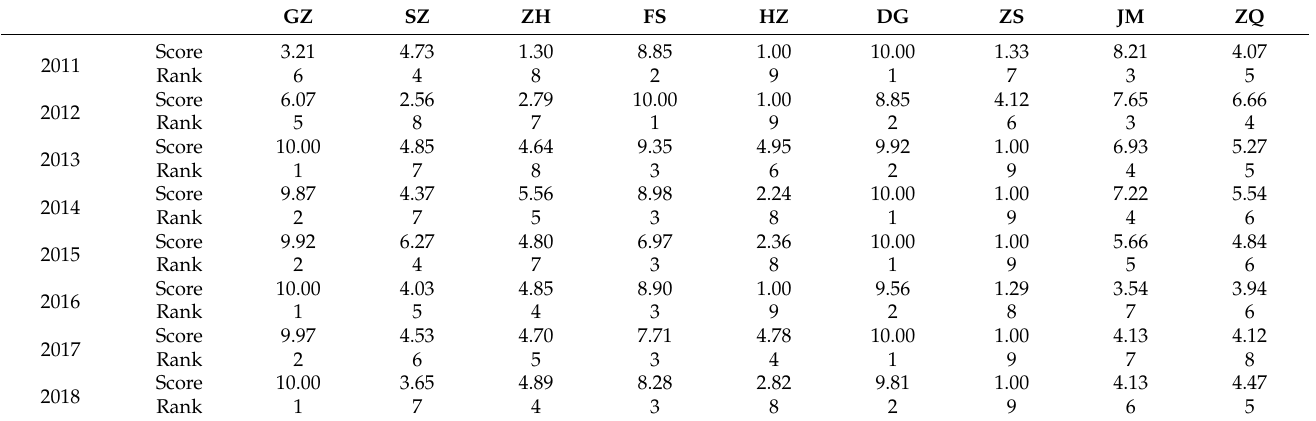
Table 4. Evaluation scores of the environmental factor.